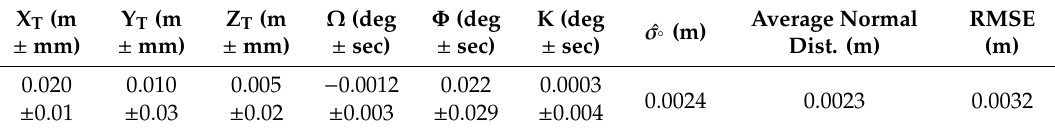
Figure 23. Cross sections illustrating the alignment quality of registered TLS and MLS point clouds for the MSE wall at Site-1. Table 2. Estimated transformation parameters and quality measures (square root of a-posteriori variance factor, average normal distance among point-patch pairs, and RMSE of the normal distances) following the registration of the Riegl and ZF scans in a given drive run at Site-1.